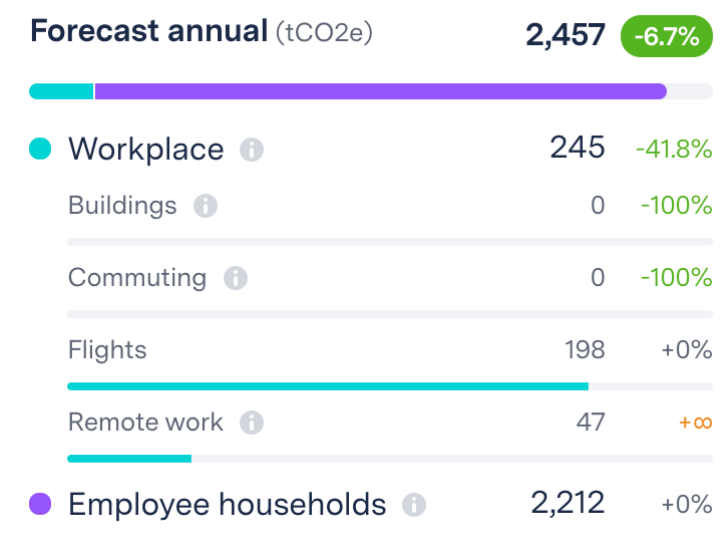
Figure 3. Forecast—fully remote. Source: Planety.com, accessed on 9 September 2021.